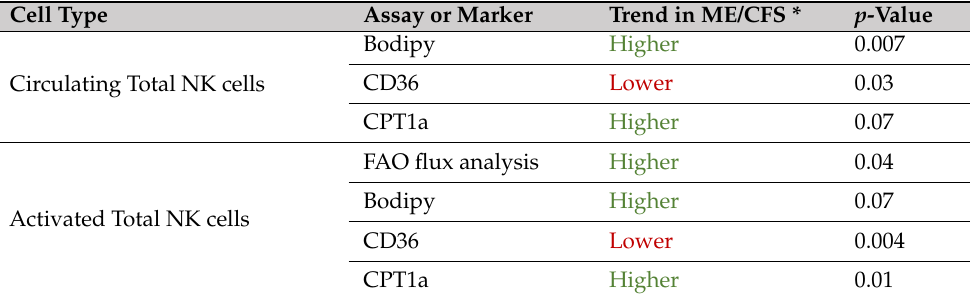
Table 2. Summary of results concerning FAO in ME/CFS vs. control NK cells. Cell Type Assay or Marker Trend in ME/CFS * p -Value Bodipy Circulating Total NK cells